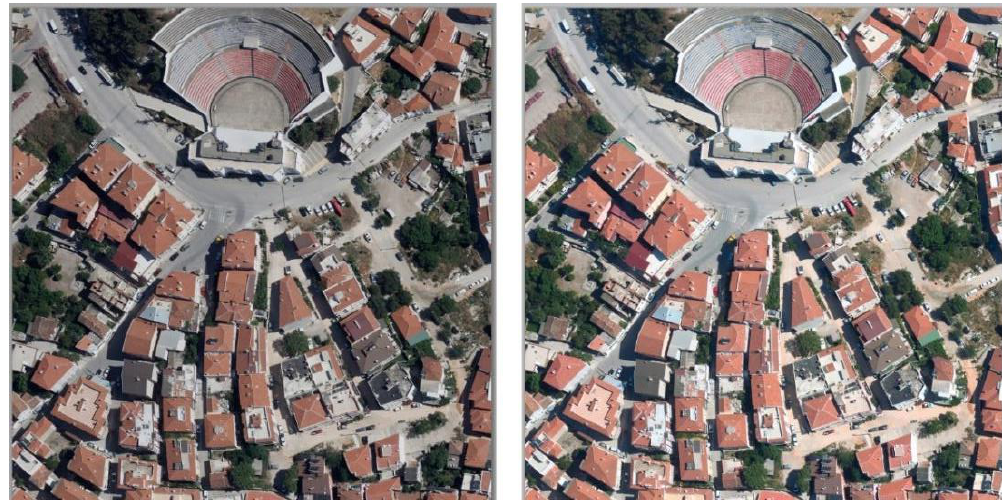
Figure 17. Raw aerial image ( left ) and pre-processed (color-enhanced) image ( right ) of Cesme Town.